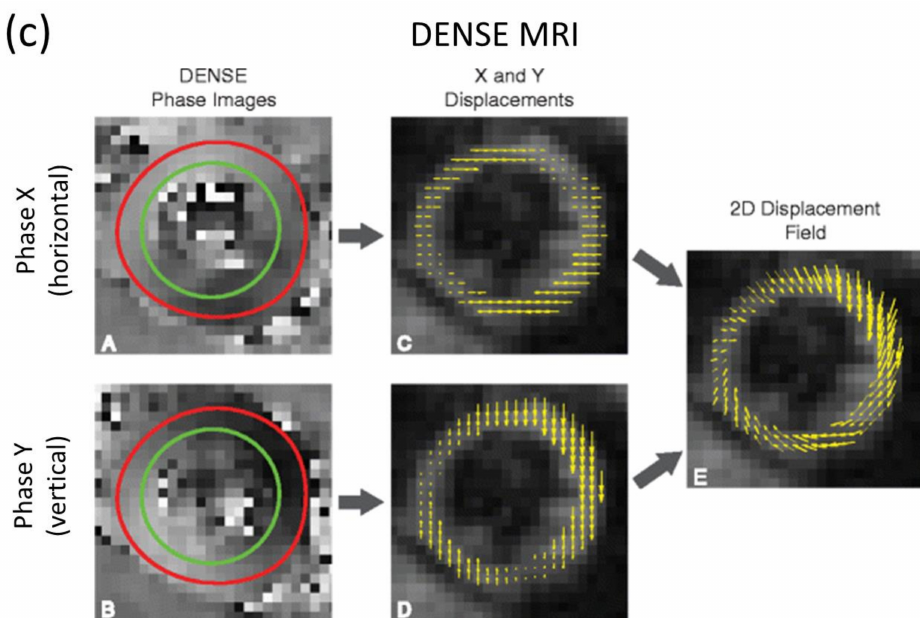
Figure 8. Examples of image-based kinematics of the left ventricular myocardium with ( a ) Speckle tracking ultrasound (Reprinted/adapted with permission from Ref. [169]. 2020, Alessandra M. Ferraro et al.; open access) (Left) Dots indicate speckle-kernel location and identification, (right) green lines indicate trajectory through the cardiac cycle. ( b ) Tissue tagging (Reprinted/adapted with permission from Ref. [170]. 2012, The Radiological Society of North America). Tissue tagging estimates kinematics by tag-to-tag tracking from diastole to systole. Transversal (green lines) and diagonal (red lines) tag-to-tag dimensions are measured at diastole (left column) and systole (middle column), their difference can be used to measure displacement and deformation (red lines in right column). ( c ) DENSE MRI (Reprinted/adapted with permission from Ref. [171]. 2015, Wehner et al.; licensee BioMed Central, open access). DENSE MRI resolves pixel-wise displacements by processing phase data for each direction. Red and green contours represent segmented luminal and adventitial boundaries, yellow arrows represent the phase-encoded